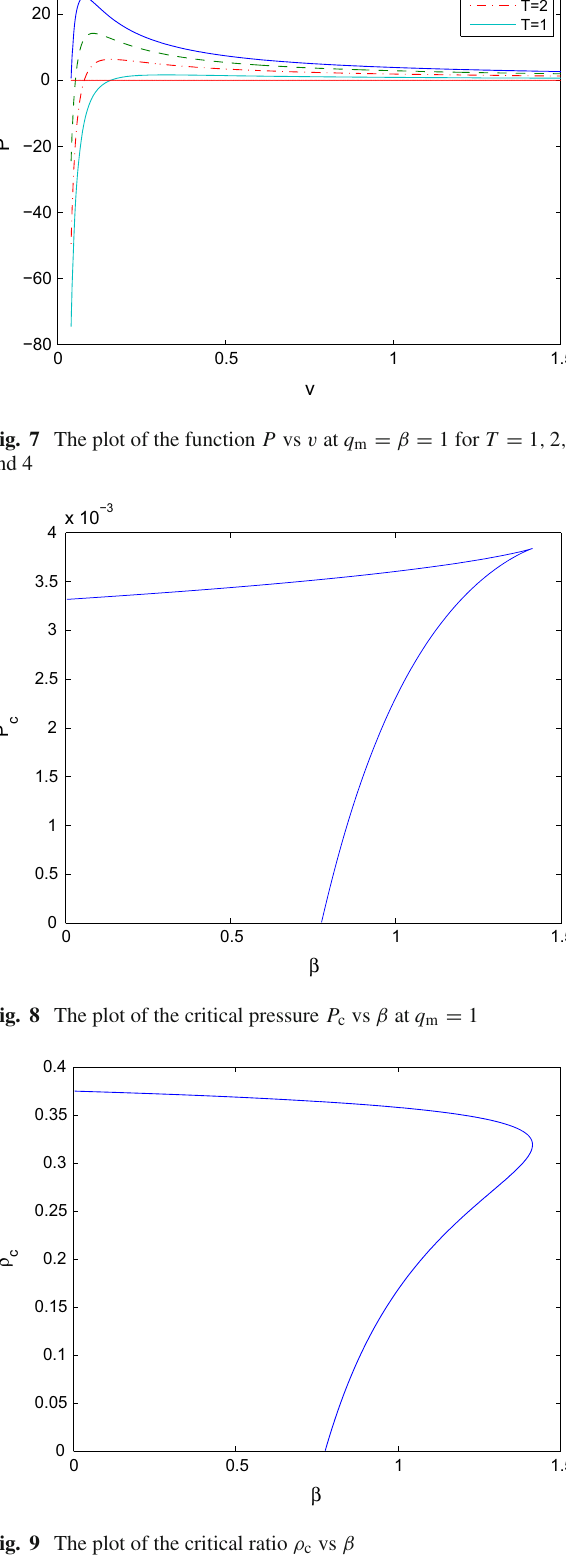
Fig. 9 The plot of the critical ratio ρ c vs